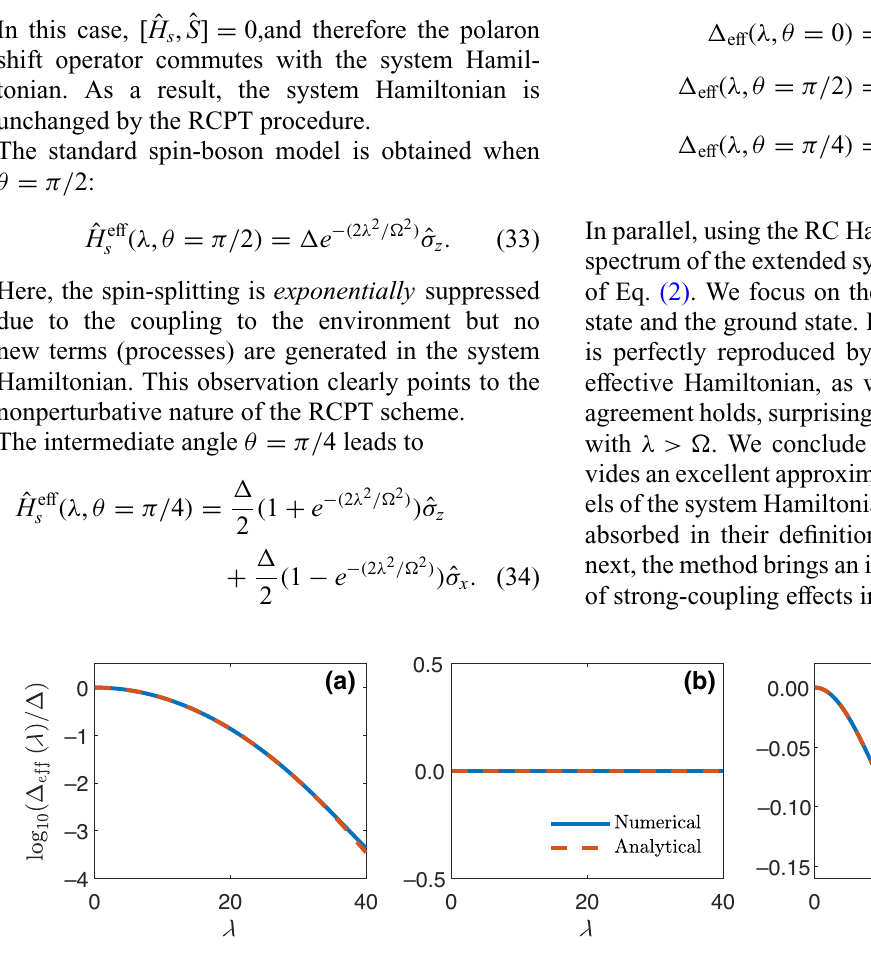
FIG. 3. The spectrum of the generalized spin boson model. We display (cid:11) eff (λ) , the energy gap between the first-excited-state and ground-state eigenenergies of the spin system as a function of the system-bath coupling for three different angles: (a) θ = π/ 2, (b) θ = 0, and (c) θ = π/ 4. Analytical expressions obtained from the effective spin splittings [see Eqs. (35)–(37)] (dashed lines) agree perfectly with results from the numerical diagonalization of Eq. (2), applied to the generalized spin-boson model (solid lines). The parameters used here are (cid:11) = 1 and (cid:5) =